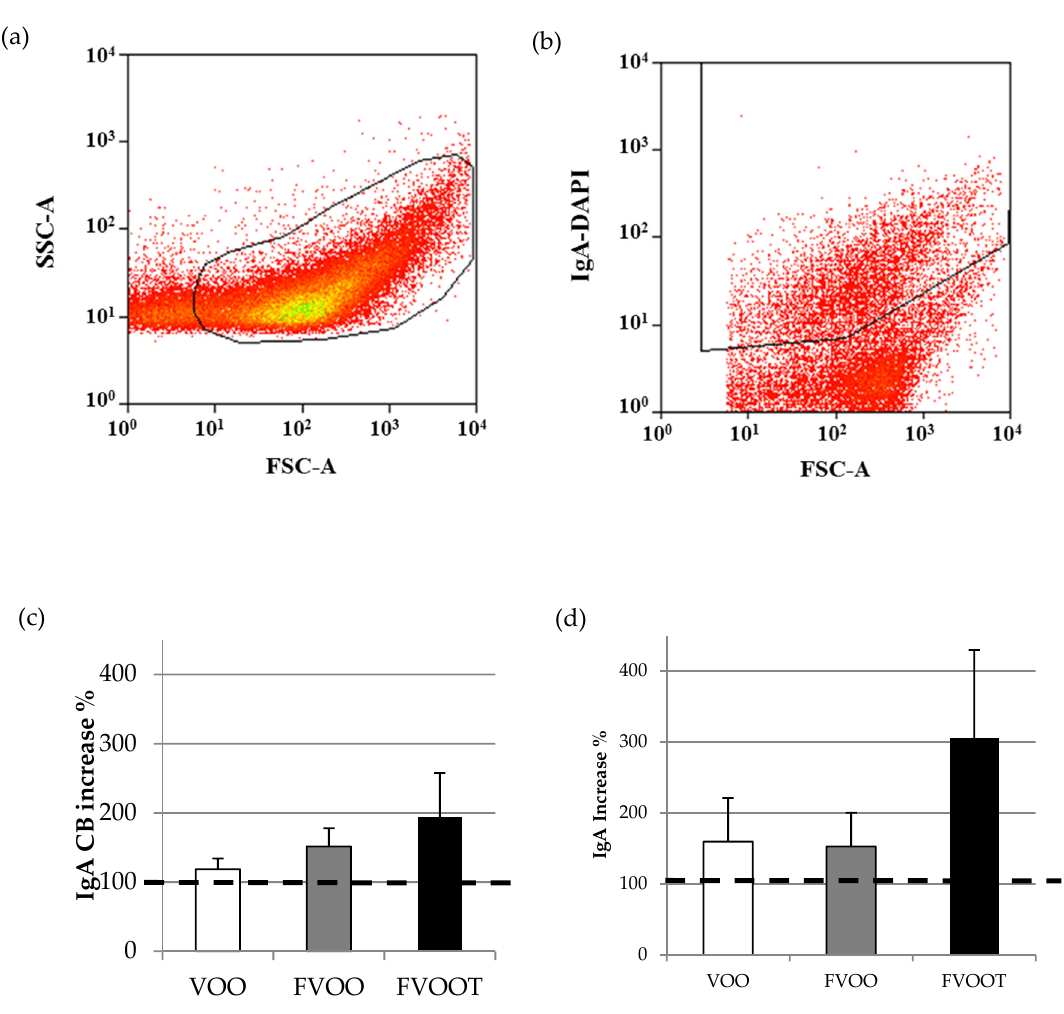
Figure 1. Representative biparametric cytogram showing the ( a ) initial acquisition gate to select the bacterial population according to its forward ‐ scatter characteristic (FSC)/side ‐ scatter characteristic (SSC) signals. ( b ) Cytogram representing the amount of bacteria coated to IgA from the total of bacteria stained with 4 ′ ,6 ‐ diamidino ‐ 2 ‐ phenylindole (DAPI). Percentage of increase of fecal IgA coating bacteria ( c ) and IgA ( d ) with each olive oil intervention versus pre ‐ intervention values (considering pre ‐ intervention values as 100%). Dietary interventions: 25 mL/day extra virgin olive oil containing: VOO, 80 mg/kg of phenolic compounds (PC) from olive oil; FVOO, 500 mg/kg of PC from olive oil; FVOOT, 250 mg/kg of PC from olive oil and 250 mg/kg from thyme.